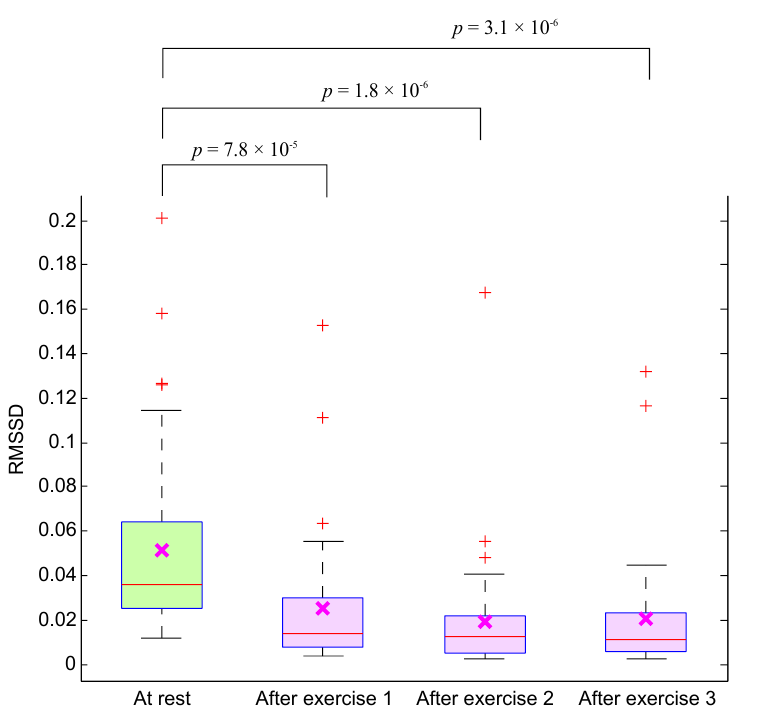
Figure 3. Boxplot of the root mean square of successive differences (RMSSD) of PPG signals measured before and after simulated heat stress induction. Here, the p -value is calculated using the paired Mann–Whitney test ( p ≤ 0 . 05 was considered